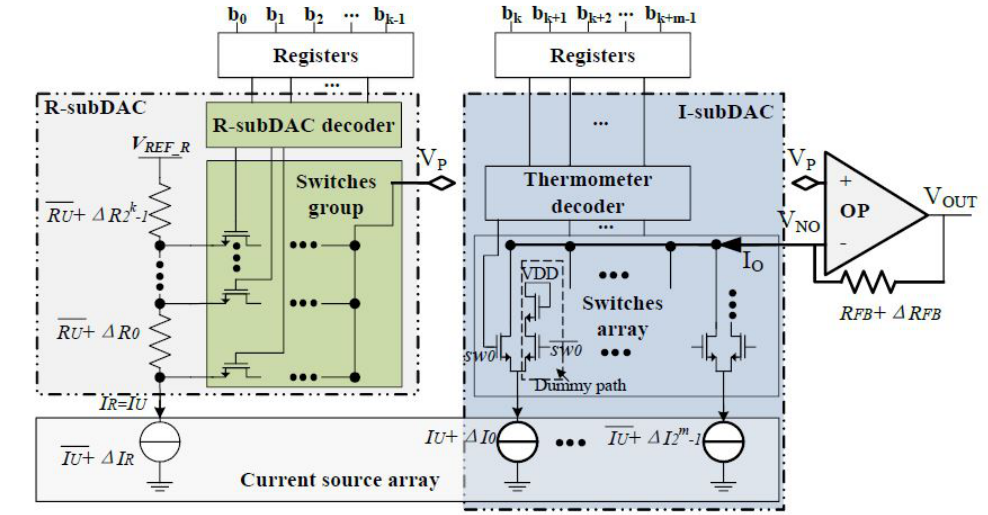
Figure 1. The k + m bits resistor-string and current-steering-array hybrid DAC (R-I DAC) with the resistor’s and current’s mismatches.